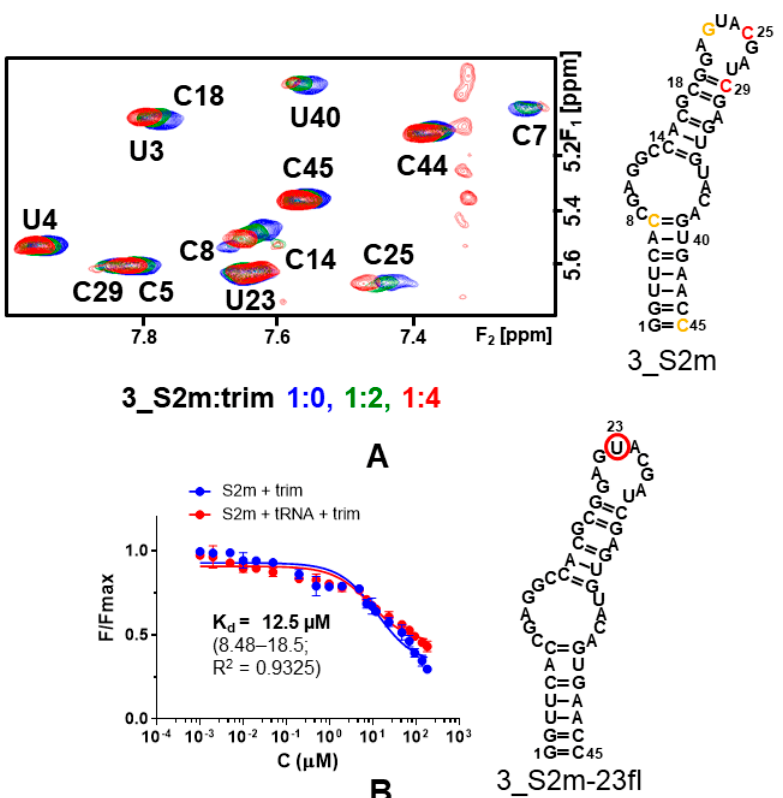
Figure 5. Recognition of the SCoV2 3’UTR S2m stem–loop by trim. ( A ) Interaction between 3_S2m and trim monitored by NMR spectroscopy. The pyrimidine H5-H6 region of the TOCSY spectrum (60 ms mixing time, 25 ◦ C) of 3_S2m (blue) is superposed on the spectra of complexes with increasing RNA–ligand molar ratios, color-coded as indicated in the graph. On the right, the location of the ligand binding sites in the 3_S2m hairpin are indicated by highlighting the nt whose protons underwent broadening or chemical shift variations greater than two (orange) and three (red) standard deviations from the mean perturbation (0.028 and 0.042 ppm) upon the addition of four equivalents of ligand. To map the binding sites, we monitored the chemical shift variations of 63 aromatic, H1’, and H2’ 3_S2m RNA resonances with TOCSY and NOESY experiments. Conditions: 120 µ M 3_S2m, 50 mM KCl, 25 ◦ C. ( B ) Interaction between 3_S2m-23fl and trim monitored by fluorescence intensity. The experiments were carried out in the absence (blue) and presence (red) of a 100-fold molar excess of unlabeled competitor tRNA. The error bars represent standard deviations of three independent experiments. Conditions: 100 nM 3_S2m-23fl, 150 mM NaCl, 25 ◦